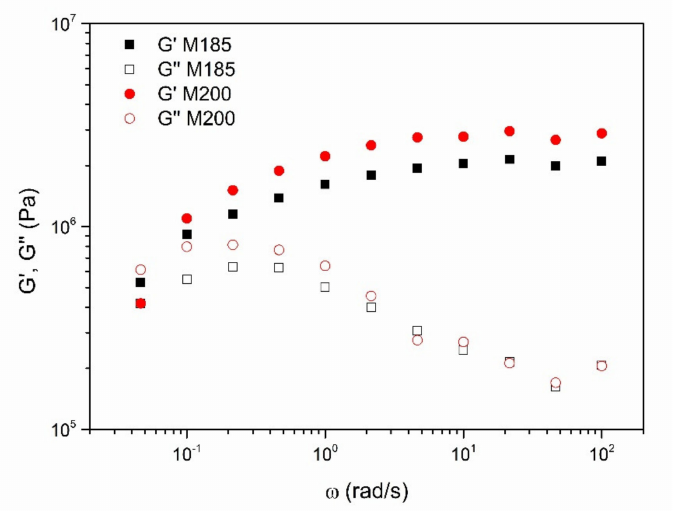
Figure 2. Evolution of the storage and loss viscoelastic moduli with frequency for both M185 and M200 mortar samples.